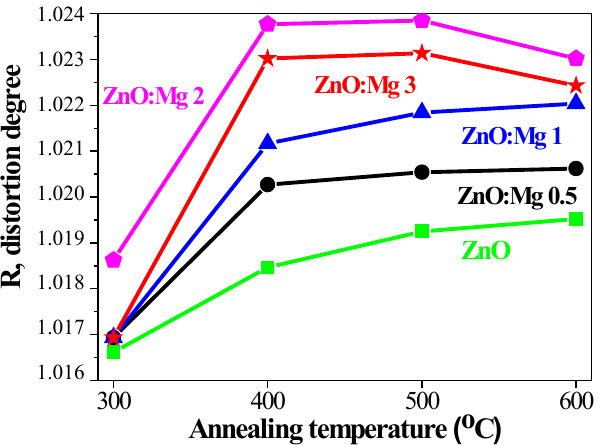
Figure 8. Crystal lattice distortion degree, R , estimated for ZnO and ZnO:Mg films depending on annealing temperatures.